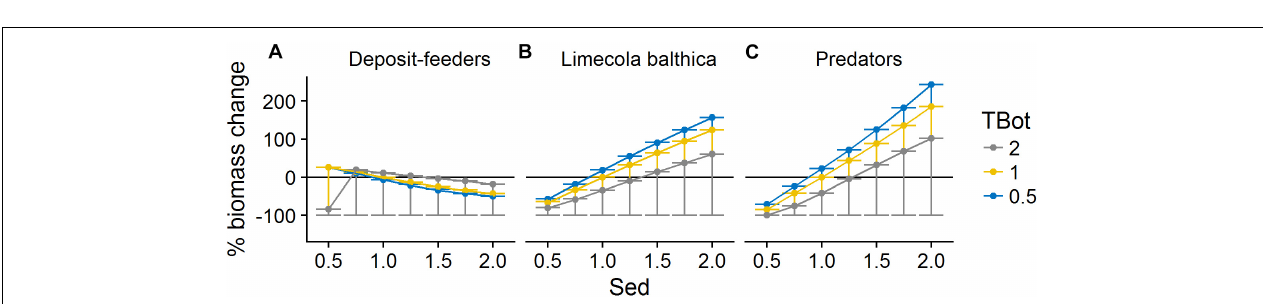
FIGURE 5 | Change in biomass of adult (A) and juvenile (C) cod and adult (B), and juvenile (D) sprat as a function of their respective egg production forcing ( Table 1 ) at four different levels of P/B, where 1 denotes baseline forcing. Biomass change is relative to baseline equilibrium value. Error bars show the variability in biomass change due to varying forcing factors other than P/B and egg production. Horizontal line indicates no change. Forcing abbreviations are explained in Table 1 .